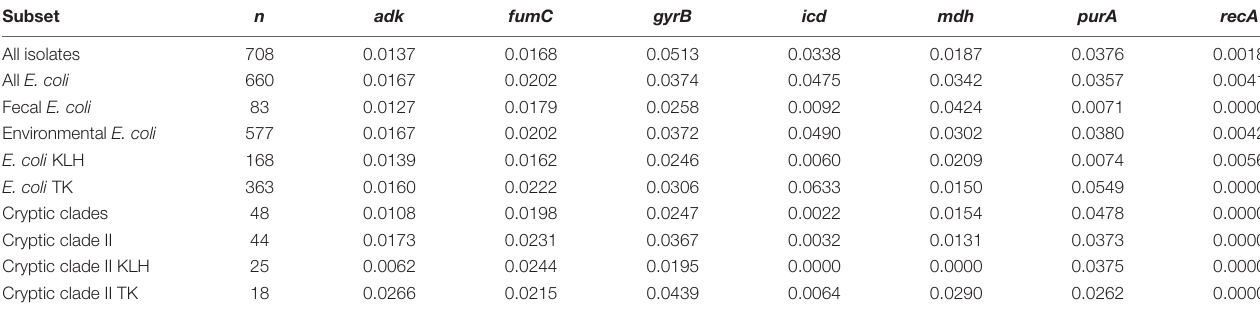
TABLE 4 | d N /d S ratio of the seven housekeeping genes.